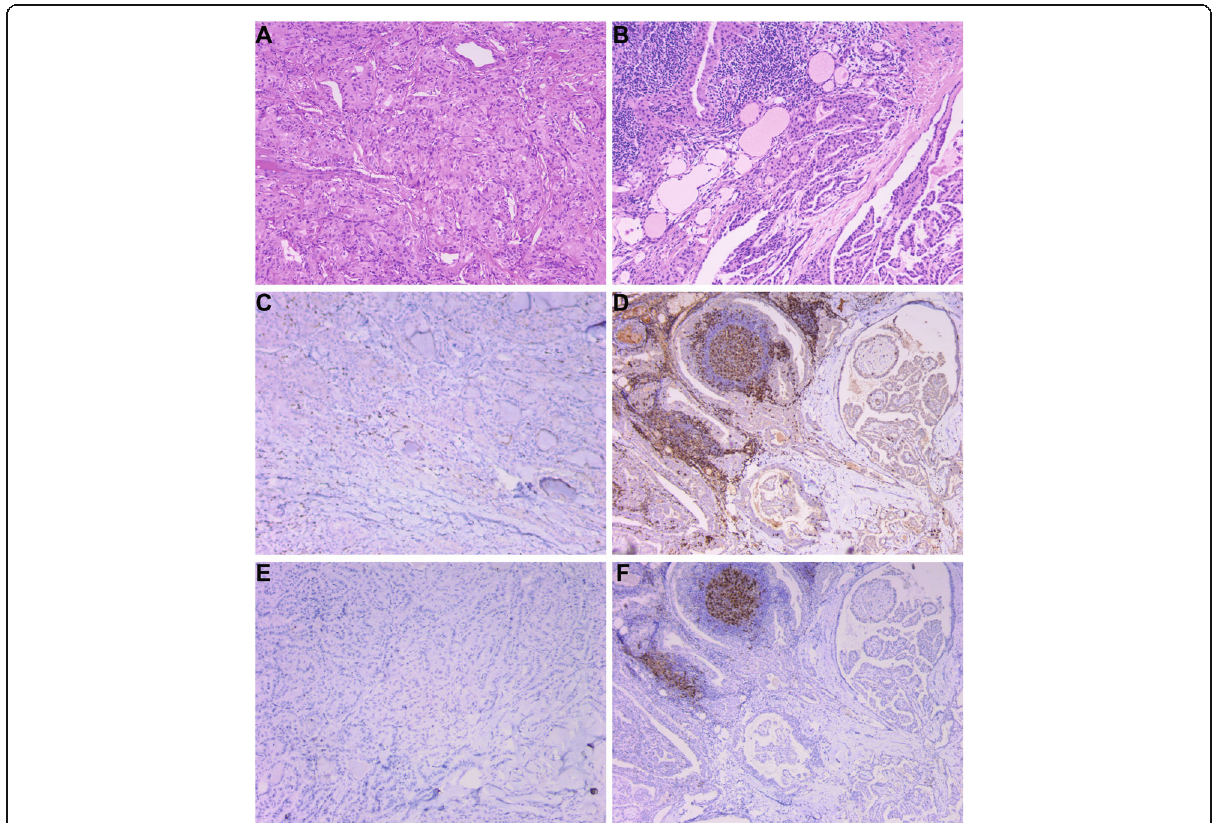
Fig. 4 The T cells infiltration in thyroid by immunohistochemistry. A. PTC&noHT (100×). B. PTC&HT (100×). C. The CD3 expression in PTC&noHT (100×). D. The CD3 expression in PTC&HT (100×). E. The PD-1 expression in PTC&noHT (100×). F. The PD-1 expression in PTC&HT (100×)